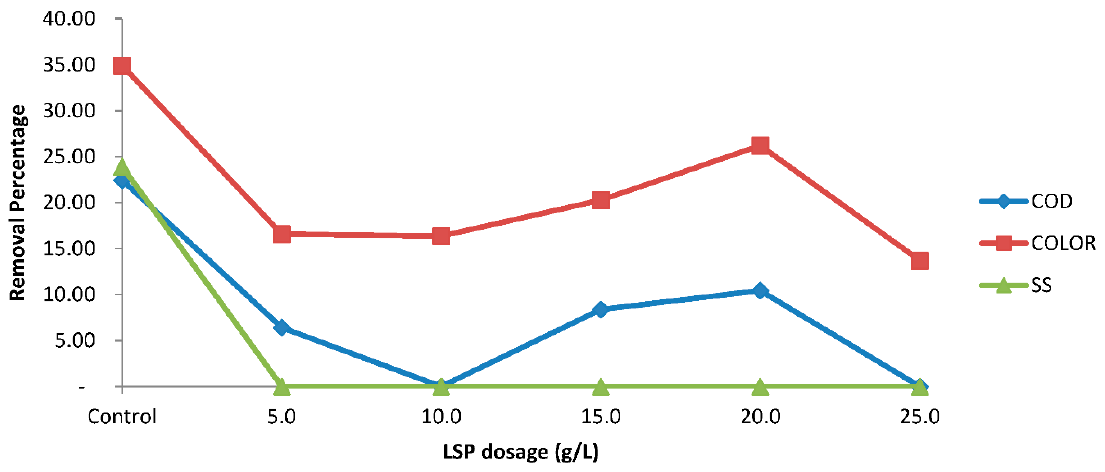
Figure 8. The effect of LSP in major dosages on the removal of color, SS, and COD at a constant pH 4.